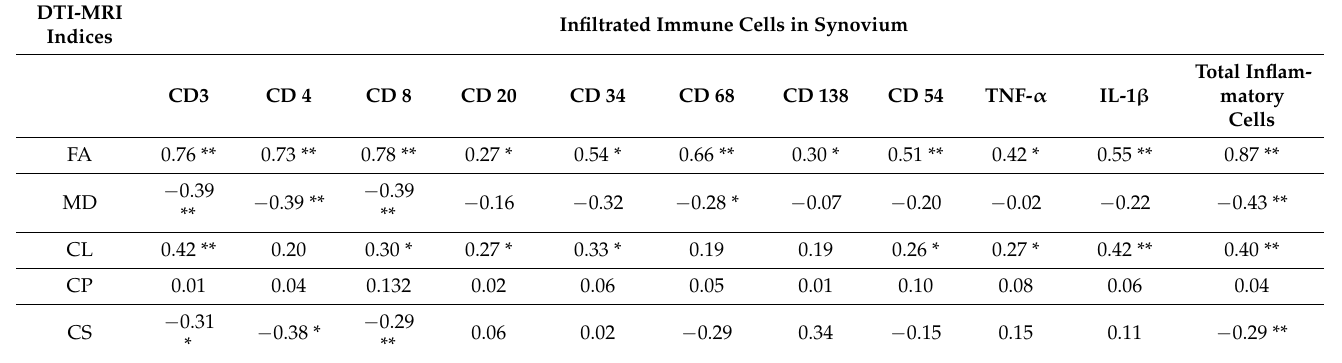
Table 4. Correlation between the values of DTI and MRI indices with various infiltrating immune cells in the synovium ( n = 80). Results are expressed as R